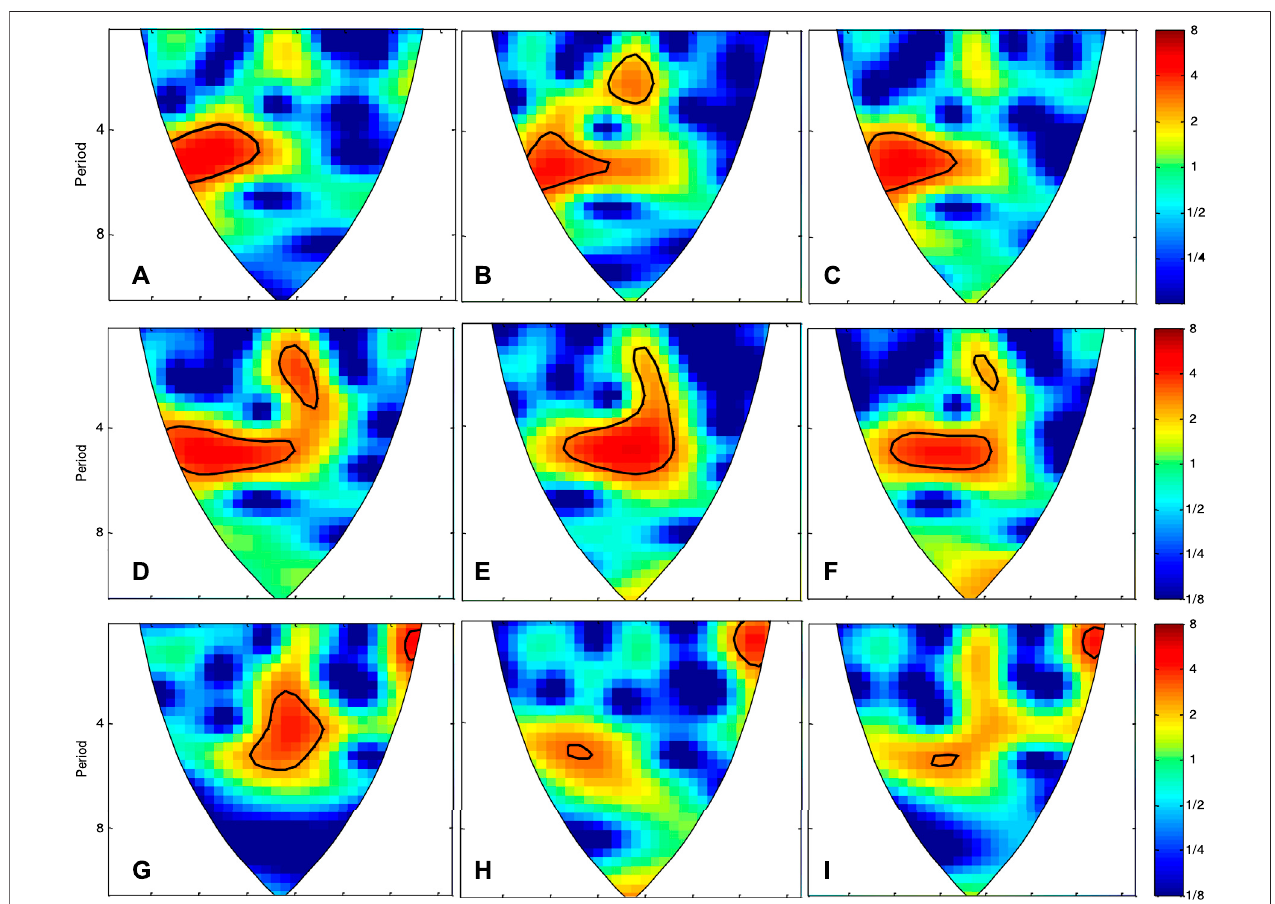
FIGURE14 | Waveletanalysis oftheWPD (left), EWSO (middle),and RLO (right) in theArabian Sea (A – C) , theBay ofBengal (D – F) , and the South China Sea (G – I) for the period 1979 – 2014.